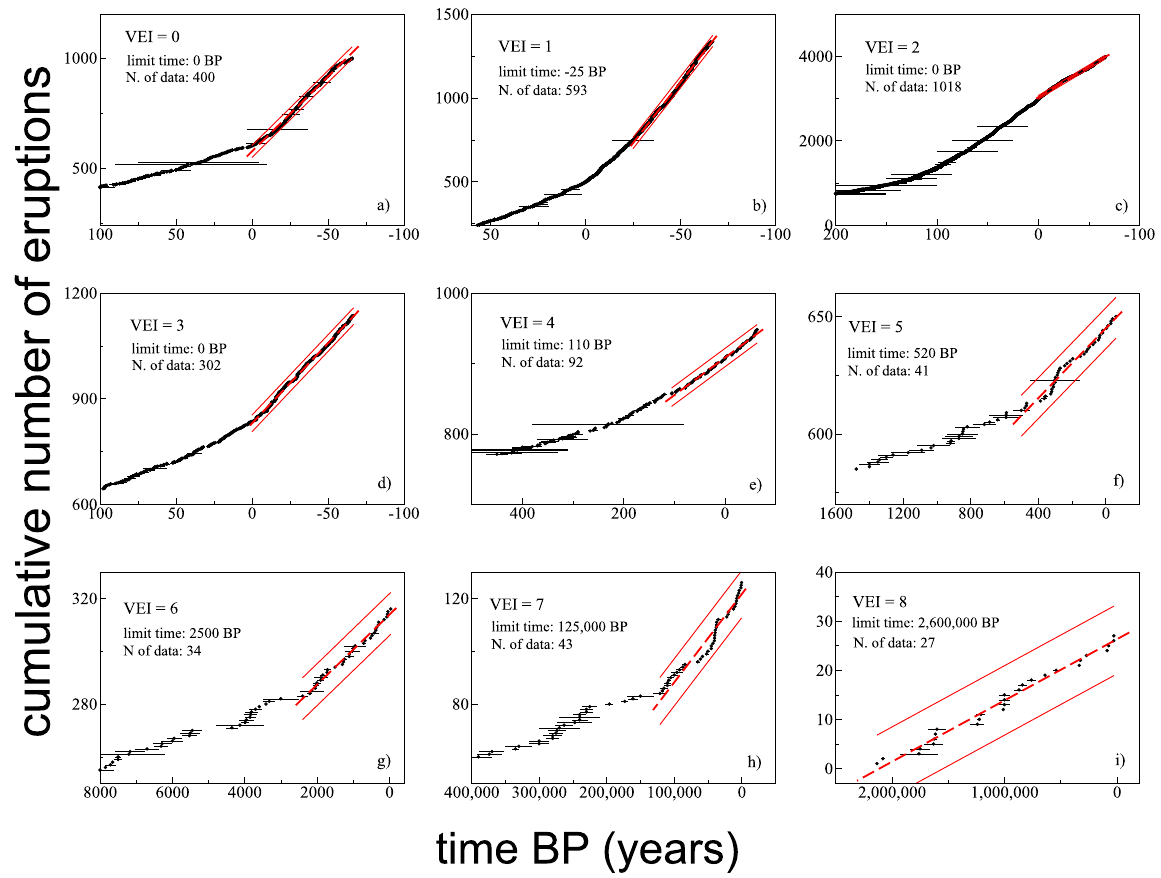
Figure 1. Cumulative plots of the number of eruptions with time for each individual VEI class. The plots represent a zoom in a (relatively) recent time region where approximately linear trends emerge. The horizontal axis refers to years Before Present (BP), conventionally set to zero at year AD 1950. Best-fit linear trends are represented by the thick red dashed lines, while the thin solid red lines bound the 95% confidence band for expected statistical variability of data 23 . Wider confidence limits reflect lower number of data. Each panel reports the time limit of the linear region, which generally increases with increasing VEI, and the number of eruptions in such a region, which generally decreases with increasing